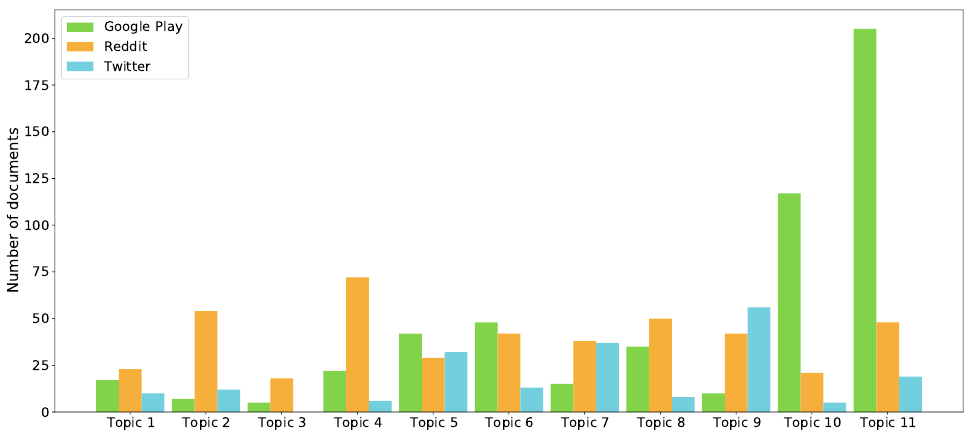
Figure 10. Annotated documents per topic and per